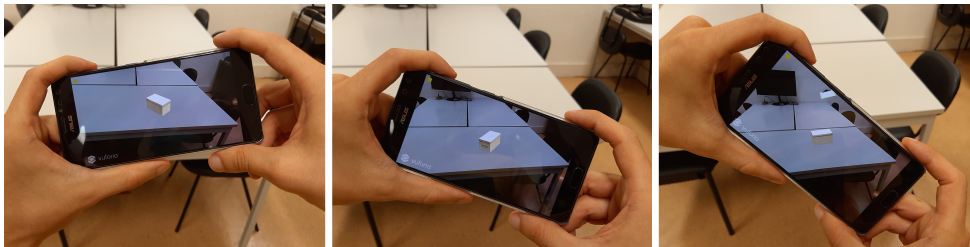
Figure 8. Handling the mobile device to control the virtual object rotation. By turning the de- vice without changing the camera point of view, the object orientation changes while maintaining its